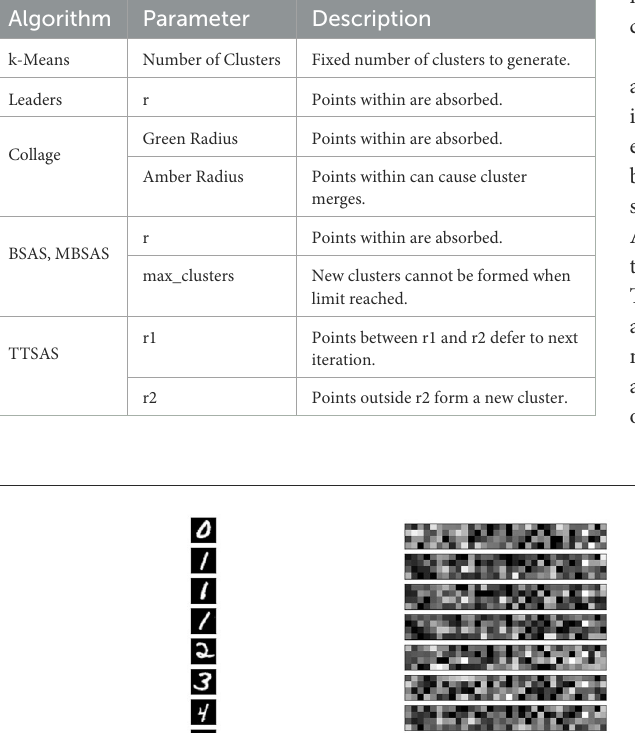
TABLE 3 Summary of clustering algorithm parameters.